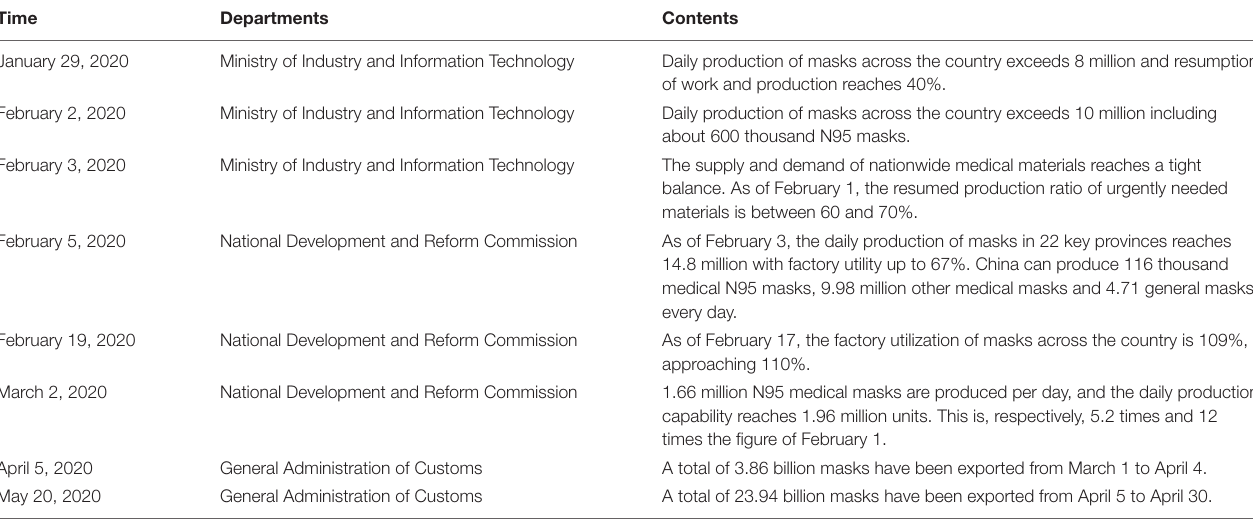
TABLE 2 | Production of masks at each